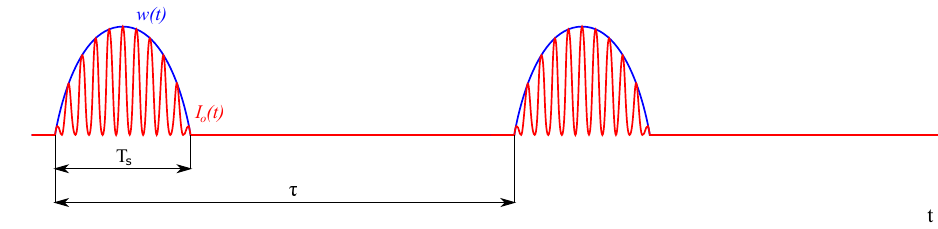
Figure 2. Proposed QCW signal